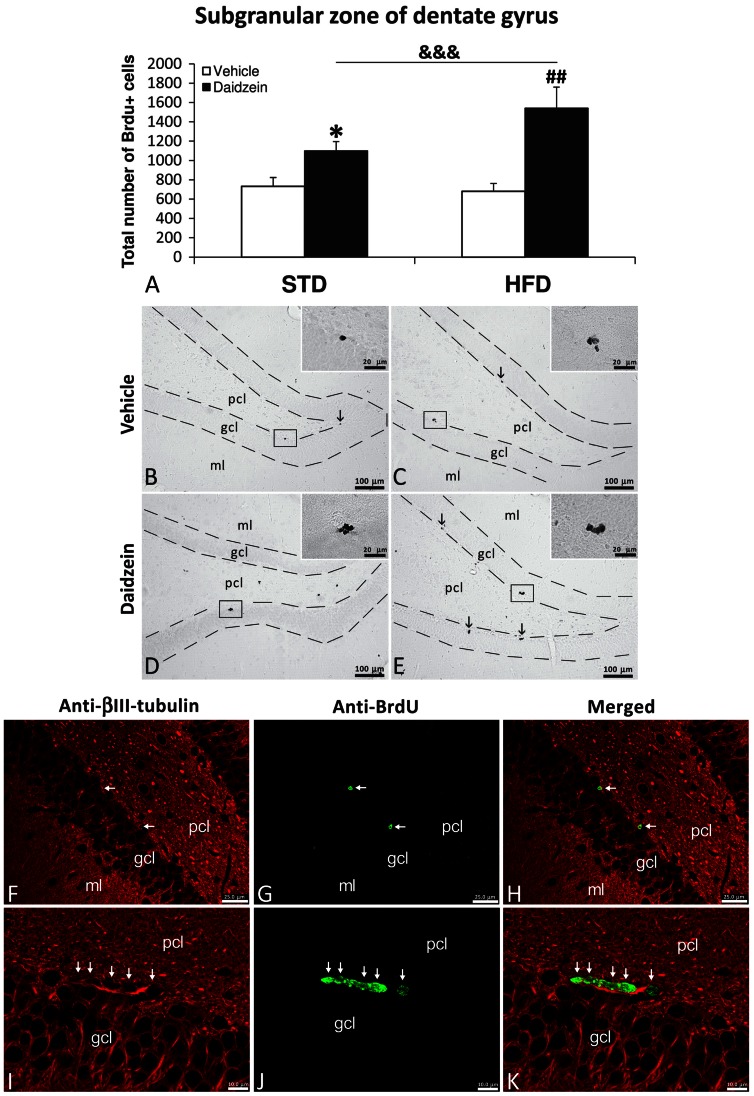
Effect of daidzein on cell proliferation in the SGZ of DG in rats fed STD and HFD by BrdU immunohistochemistry.
A) The number of positive cells is significantly greater in STD and HFD rats treated with daidzein. B–E) Representative microphotographs show low- and high- magnification (insets) views of the typical clustering of newborn cells at the inner border of the granular cell layer (arrows). F-K) Newborn cells in the SGZ showing the co-localization of the neuron-specific β3-tubulin (red) and BrdU (green) by immunofluorescence. The histogram represents the mean ± s.e.m. (n = 6–8) of the total number of BrdU-ir nuclei per experimental group. Two-way ANOVA: &&&
P<0.001 for treatment effect (vehicle vs. daidzein). Bonferroni post test: *P<0.05 vs. STD-fed rats treated with vehicle, ##
P<0.01 vs. HFD-fed rats treated with vehicle. Scale bars are included in each image.